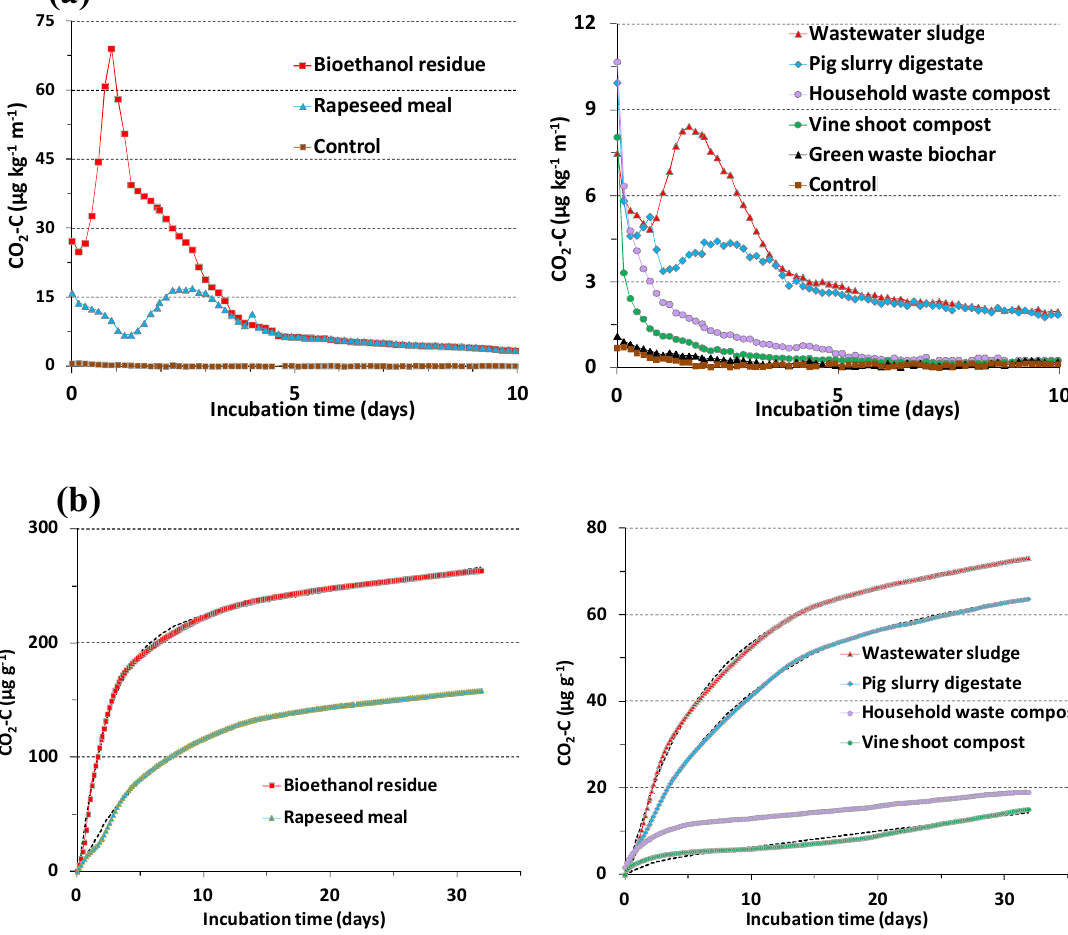
Figure 3. Rate (a) and net cumulative measured and simulated (b) CO 2 emissions from Llano de la Perdiz soil amended with different quality EOMs during a 30-day laboratory incubation. For the rate of respiration, only the first 10 days of the incubation are reported. Simulated net cumulative respiration curves are represented as dotted lines. Respiratory curves are presented on the y axis with a different scale for better